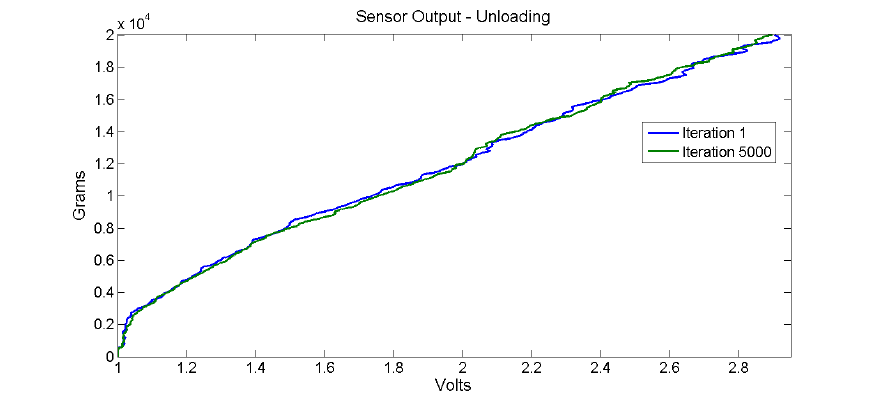
Figure 12. Raw sensor output response comparison for the unloading